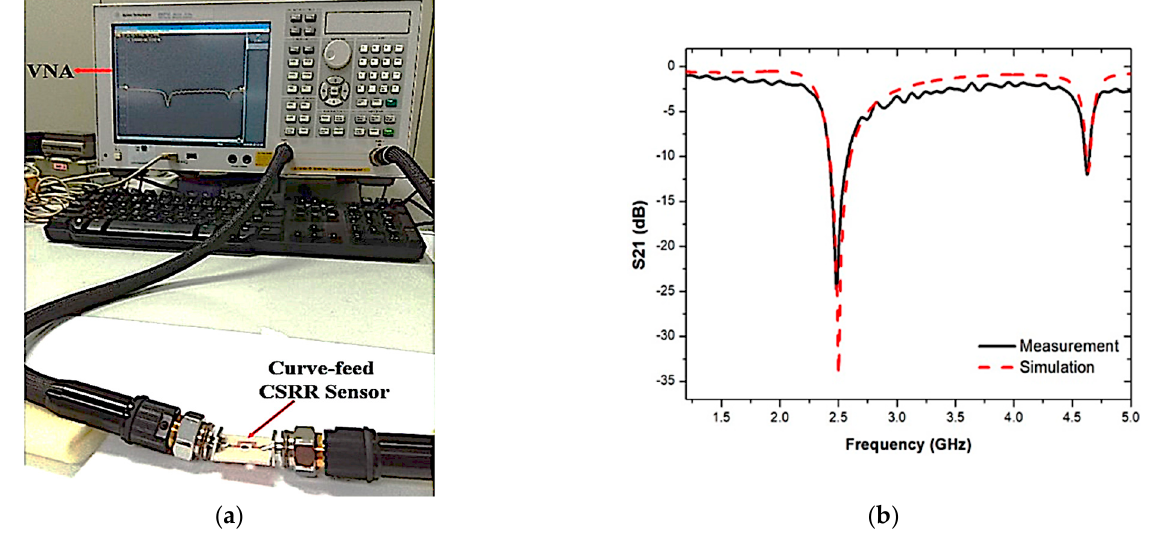
Figure 12. ( a ) Experimental setup. ( b ) Simulated and measured results of triple-rings CSRR sensor.